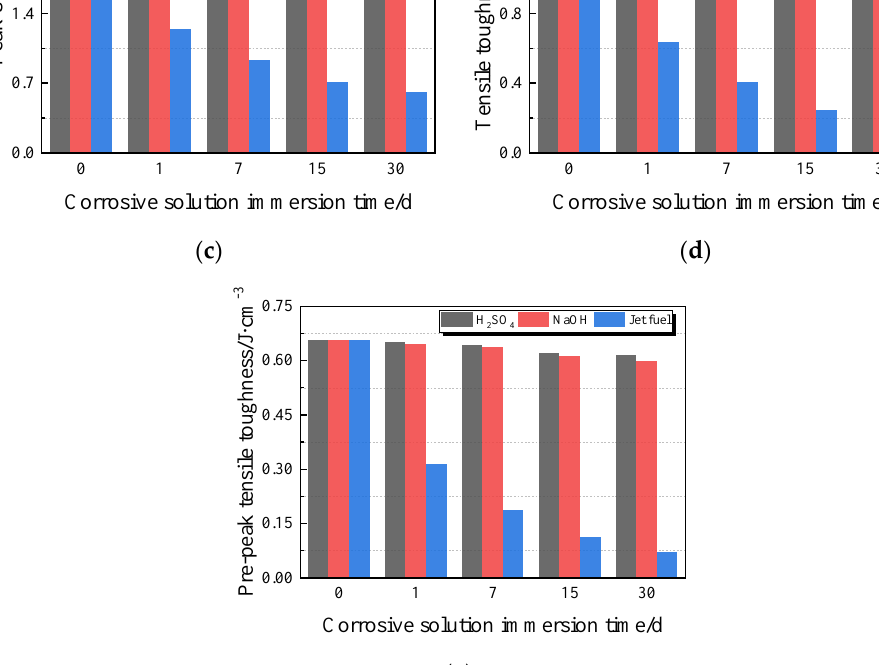
strength. ( b ) Elongation at break. ( c ) Peak strain. ( d ) Tensile toughness. ( e ) Pre-peak tensile toughness.